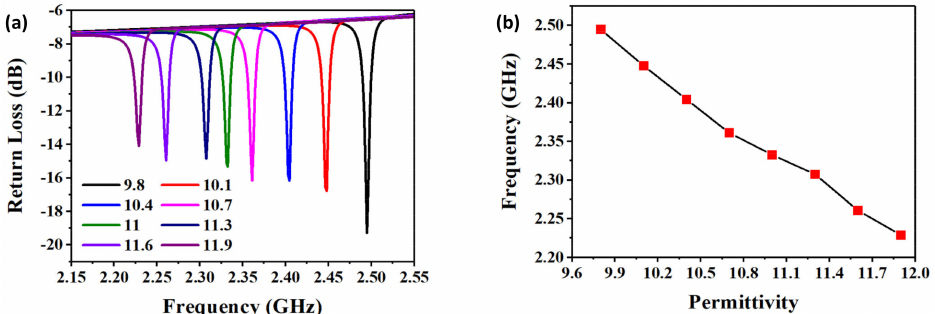
Figure 6. ( a ) Resonant frequency versus return loss with different dielectric constants. ( b ) Frequency fitting curve with different dielectric